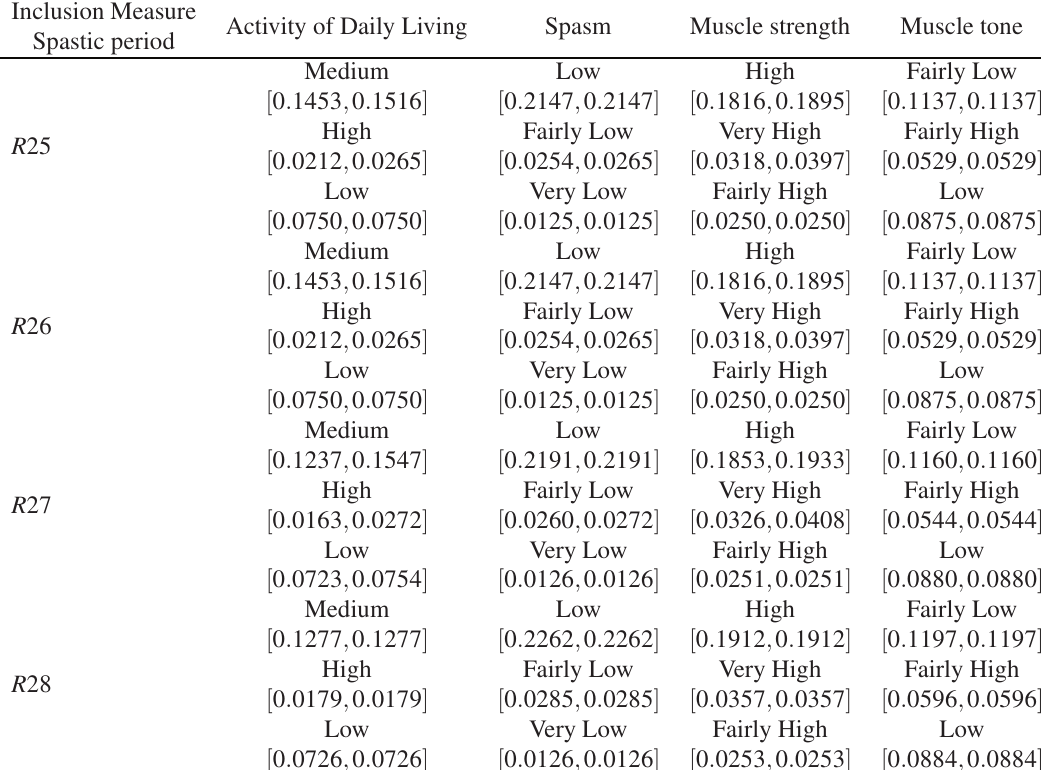
Table 2. The inclusion measure (p=1) between inputs and an- tecedent assessment of the spastic